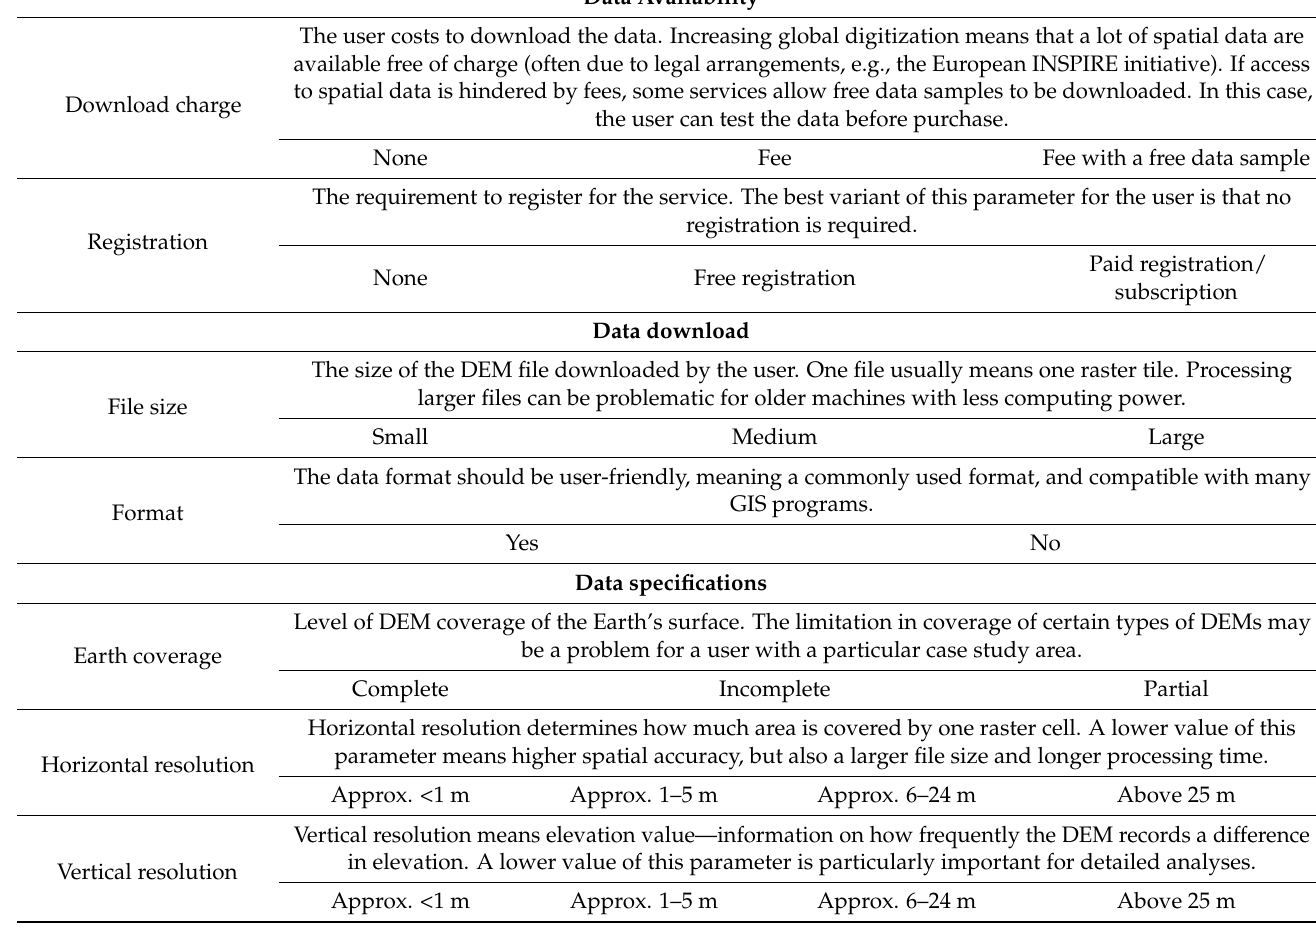
Table 3. DEM sources parameters. Source: own elaboration, on the basis of [43–46,49,50]. Data